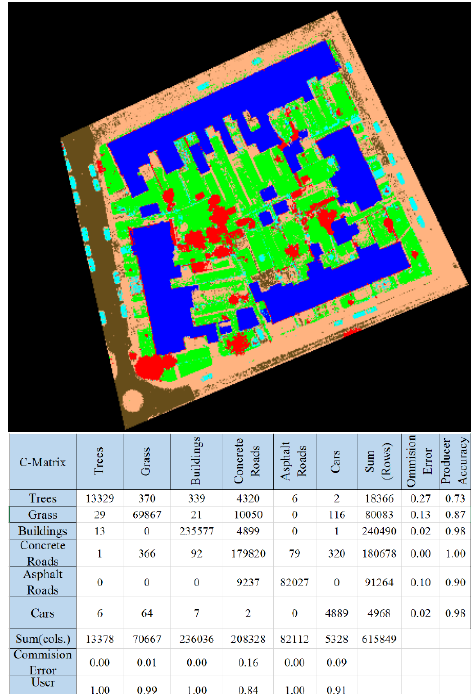
Figure 9. Final obtained classification from decision level fusion.